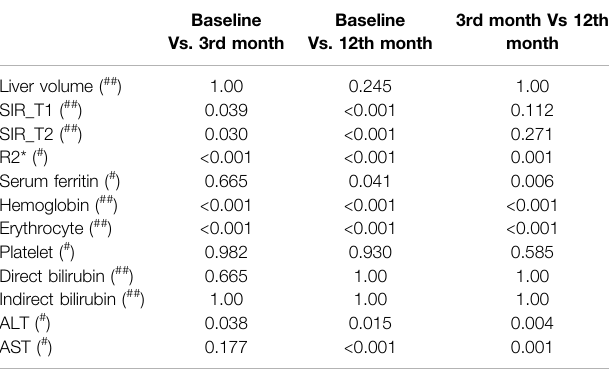
TABLE 2 | Multiple comparisons ( p values) of the baseline, 3 rd month, and 12th month groups for liver volume, hepatic muscle signal ratio, R2*, and clinical